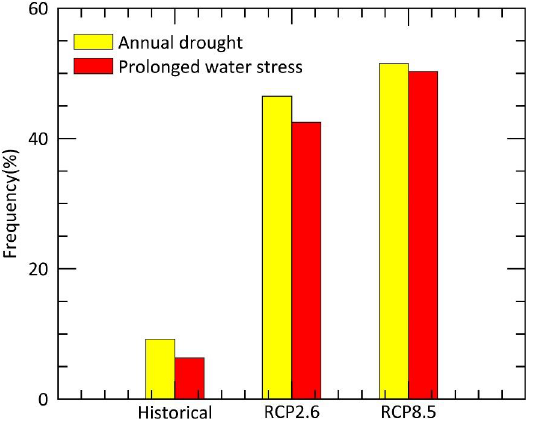
Figure 7. Compared to the historical data (1951–2005), the frequency of drought and prolonged water stress events will increase in Yunnan under the RCP2.6 and RCP8.5 projection scenarios